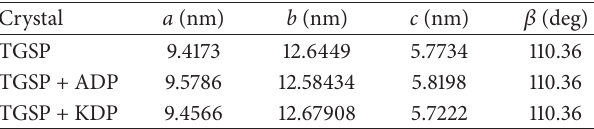
Table 4: Lattice parameter values of grown